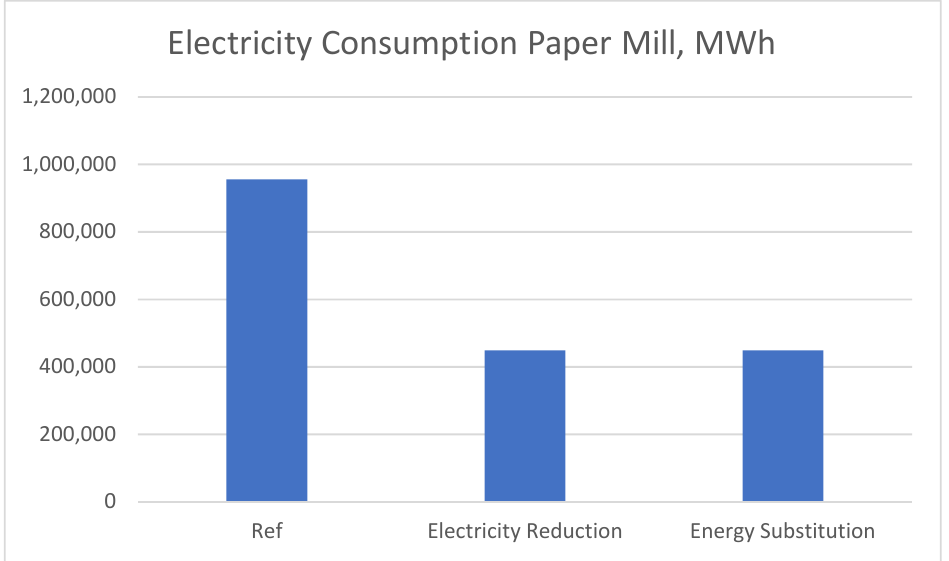
Figure 4. The electricity consumption in the paper mill (mechanical pulping process + paper machines). The possibility to sell power (electricity) is an extra income for the mills and energy company. For the pulp mill to cover the required heat in the district heating system in the energy substitution case, less power can be sold (Figure